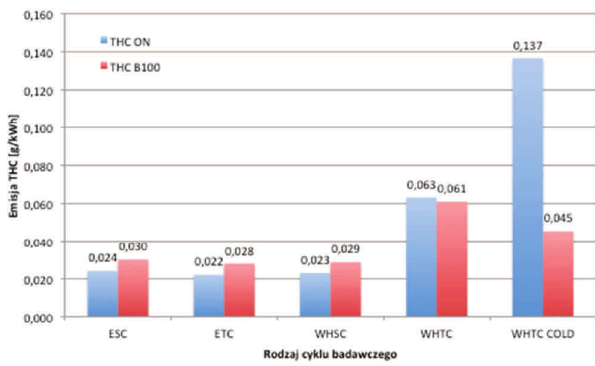
Fig. 9. Comparison of THC emission in an engine fuelled with diesel and B100, depending on the type of test